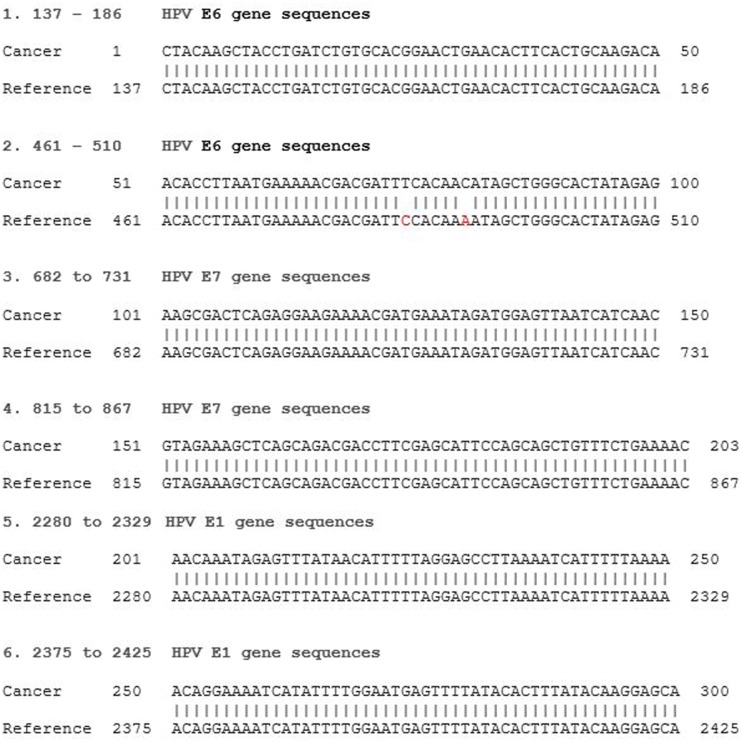
HPV type 18 E6 and E7 RNA gene sequence identified in an invasive breast cancer specimen by Next Generation Sequencing. Invasive breast cancer specimen 36 TCGAAR-A24P-01A-11R-A169-07 (see Table S1 in Supplementary Material) sequence compared to reference HPV 18 KC470228. E6 gene sequences reference 105-581, E7 590-907, E1 914-2887. The two point mutations at reference 484 and 490 have been observed in reference HPV 18 KC470209.1.